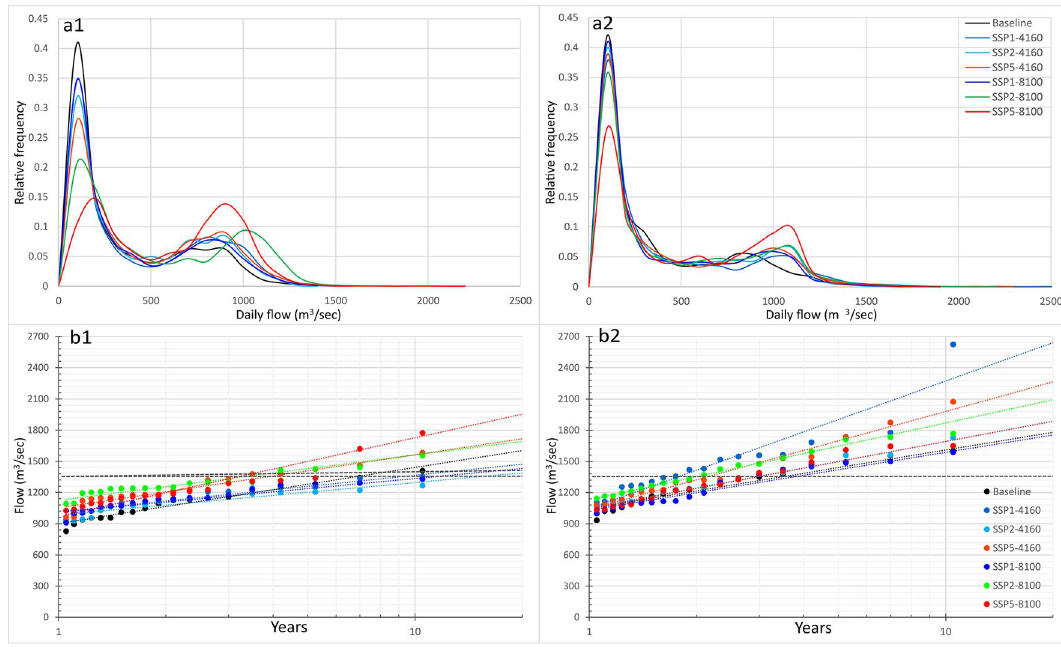
Figure 5. Normalised frequency diagram of baseline and future simulated flow based on; ( a1 ) ECE3 and ( a2 ) ESM GCM, and annual exceedance of flow under all future CC scenarios; ( b1 ) ECE3 and ( b2 ) ESM